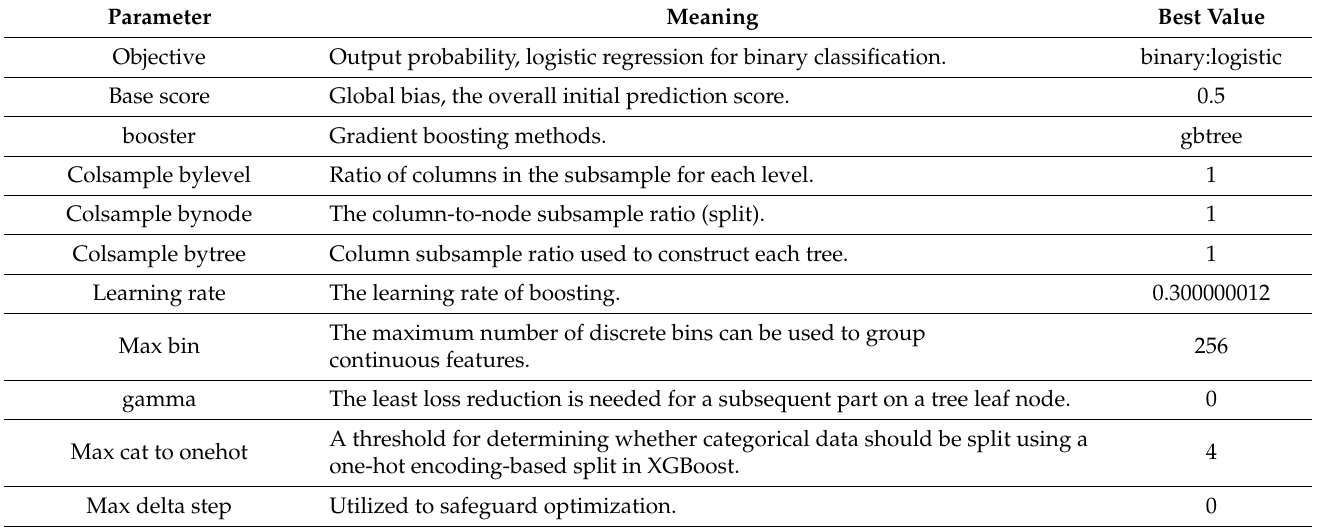
Table 6. Tuned parameters for